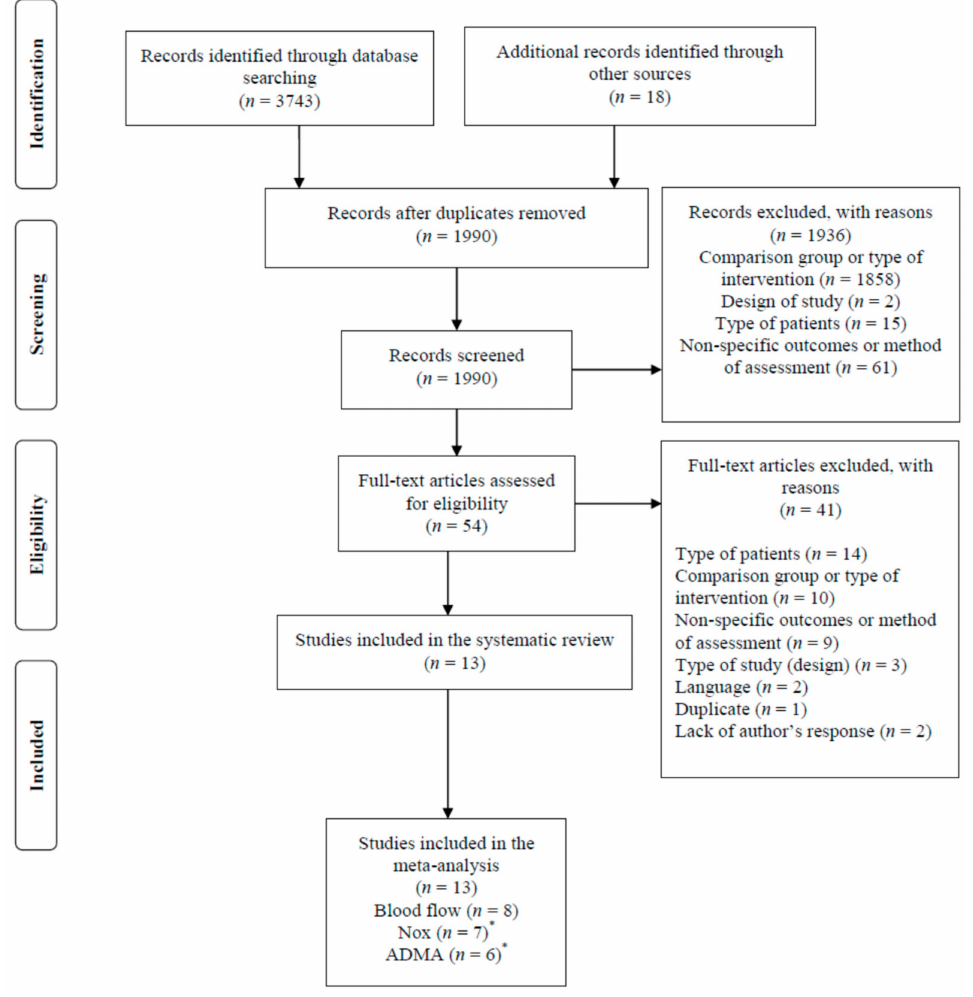
Figure 2. Flow diagram of search and selection of studies. * Nox and ADMA: Results of Schneider et al (2015) included two separated studies with two different types of patients: Coronary Artery Disease (CAD) and Peripheral Artery Disease